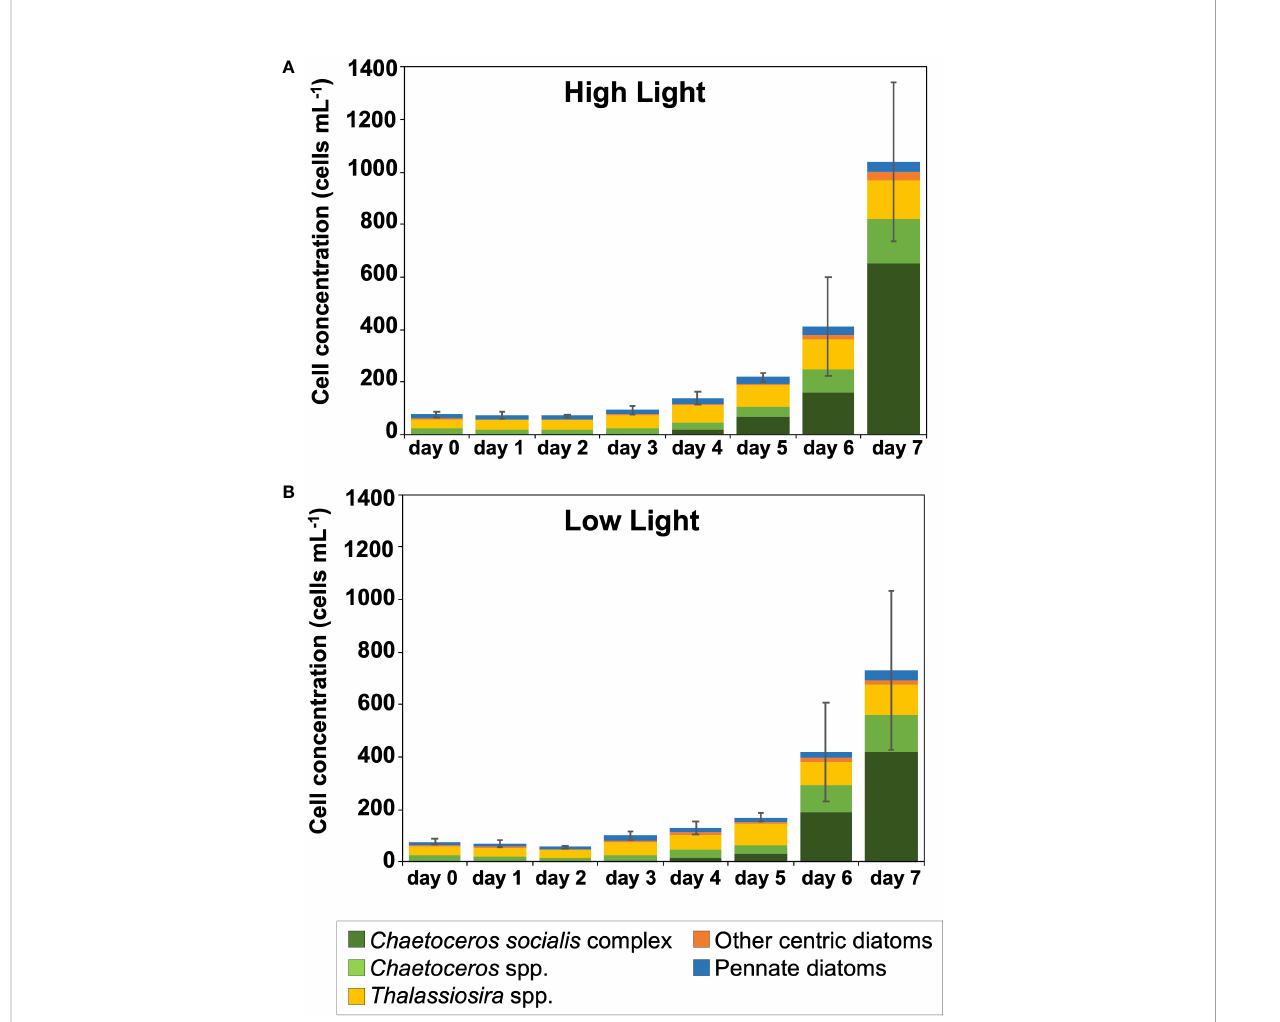
FIGURE 4 Cell concentration and composition of diatoms, which were identi fi ed and counted using an inverted light microscope, during incubation under the high (300 µmol photons m -2 s -1 ) (A) and low (30 µmol photons m -2 s -1 ) (B) light conditions. Mean values ( ± SD) indicate the average of three independent